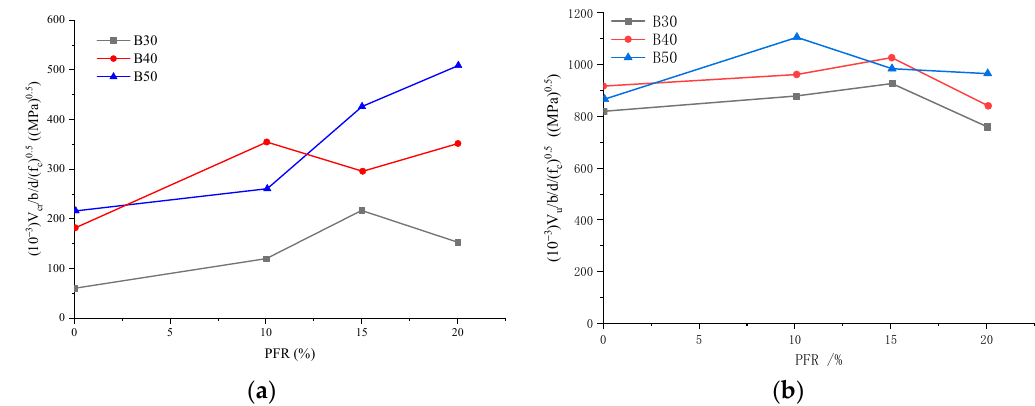
Figure 13. Effect of PFR on ( a ) normalized cracking shear force V cr and ( b ) normalized ultimate shear capacity V u .